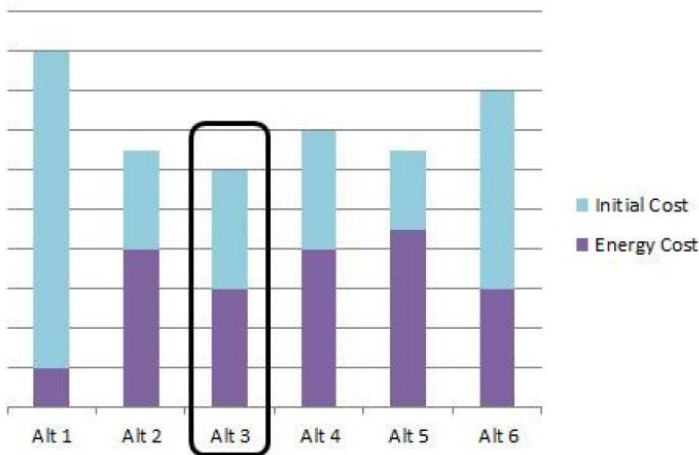
Figure 3. Concept Graph for Total Cost of Alternatives.